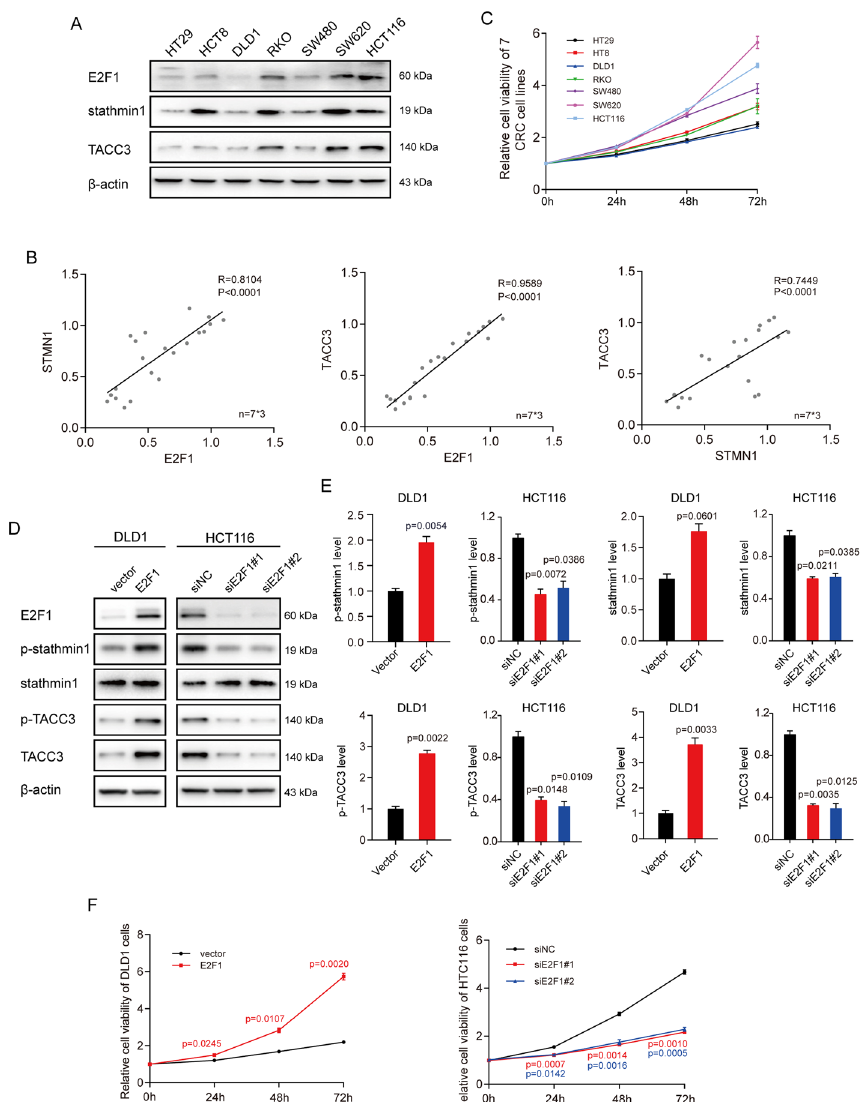
Fig. 2 Upregulation of E2F1 promotes the expression of stathmin1 and TACC3 and facilitates cell cycle progression. A Total proteins were extracted from HT29, HCT8, DLD1, RKO, SW480, SW620, and HCT116 cells. The levels of E2F1, stathmin1, and TACC3 were determined by immunoblotting. B Correlations among E2F1, stathmin1, and TACC3 levels in the CRC cell lines shown in A . Pearson’s test was used to analyze the correlations. C Viability of the cells shown in A , as measured using MTS assays 0, 24, 48, and 72 h after cell seeding. D DLD1 cells were transfected with pCMV-E2F1 or pCMV-blank vectors (final vector concentrations, 2 μg/ml). HCT116 cells were transfected with E2F1-specific or control siRNA (final siRNA concentrations, 20 nM). Samples were harvested 48 h after transfection, and the levels of the indicated factors determined by immunoblotting. E Relative levels of expression of the proteins indicated in D . F DLD1 and HTC116 cells were transfected with vectors or siRNAs as described in D . Cell viability was measured using MTS assays 0, 24, 48, and 72 h after